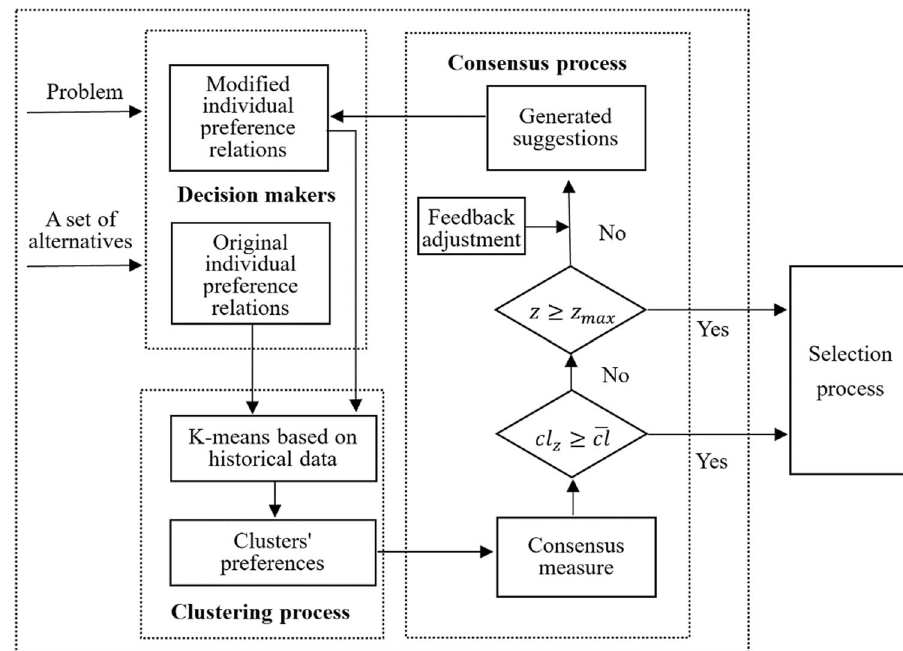
Fig. 1 The CMHP-LCRP